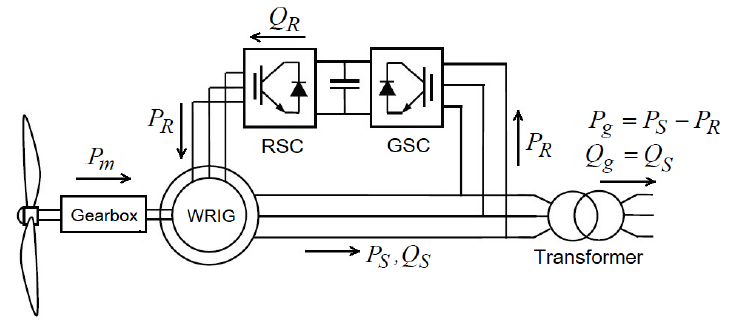
Figure 1. DFIG basic configuration.